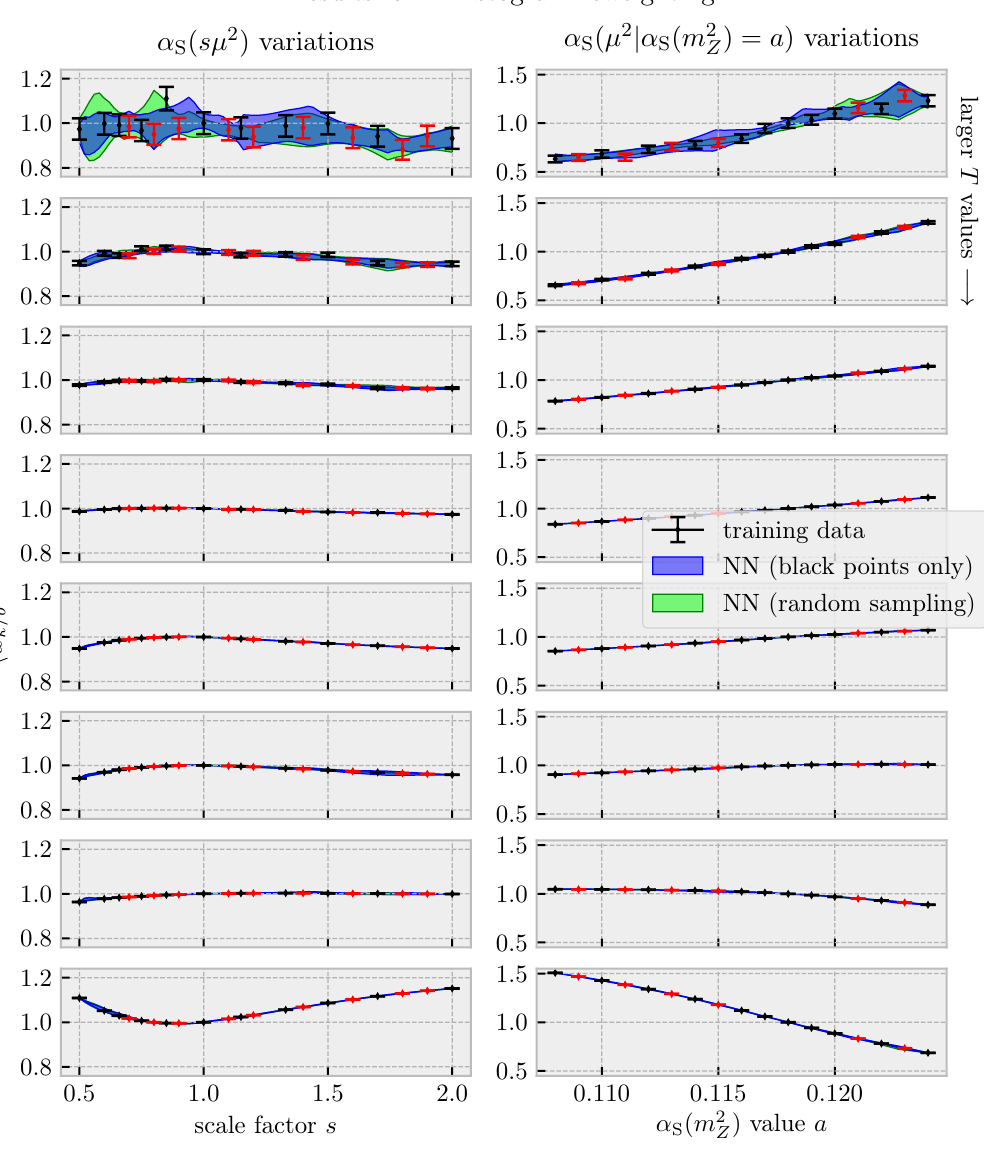
Figure 10 . A comparison between NN-predicted and true reweighting factors for a sample of bins of the Thrust T histogram, see (cid:12)gure 9. Each row corresponds to one bin, with T being in the intervals (0.58, 0.59), (0.63, 0.64), (0.88, 0.89), (0.96, 0.97), (0.97, 0.98), (0.98, 0.99), (0.99, 1.00) (from top to bottom). The data points correspond to the true reweighting factors and their Monte- Carlo errors. The black ones are used to train a (cid:12)rst set of neural networks (blue band). A random sample omitting 7 points for each variation type is used to train a second set of neural networks (green band). The most extreme variations are always kept in the training set. The uncertainties corresponds to the Monte-Carlo error of the training data as described in the text.